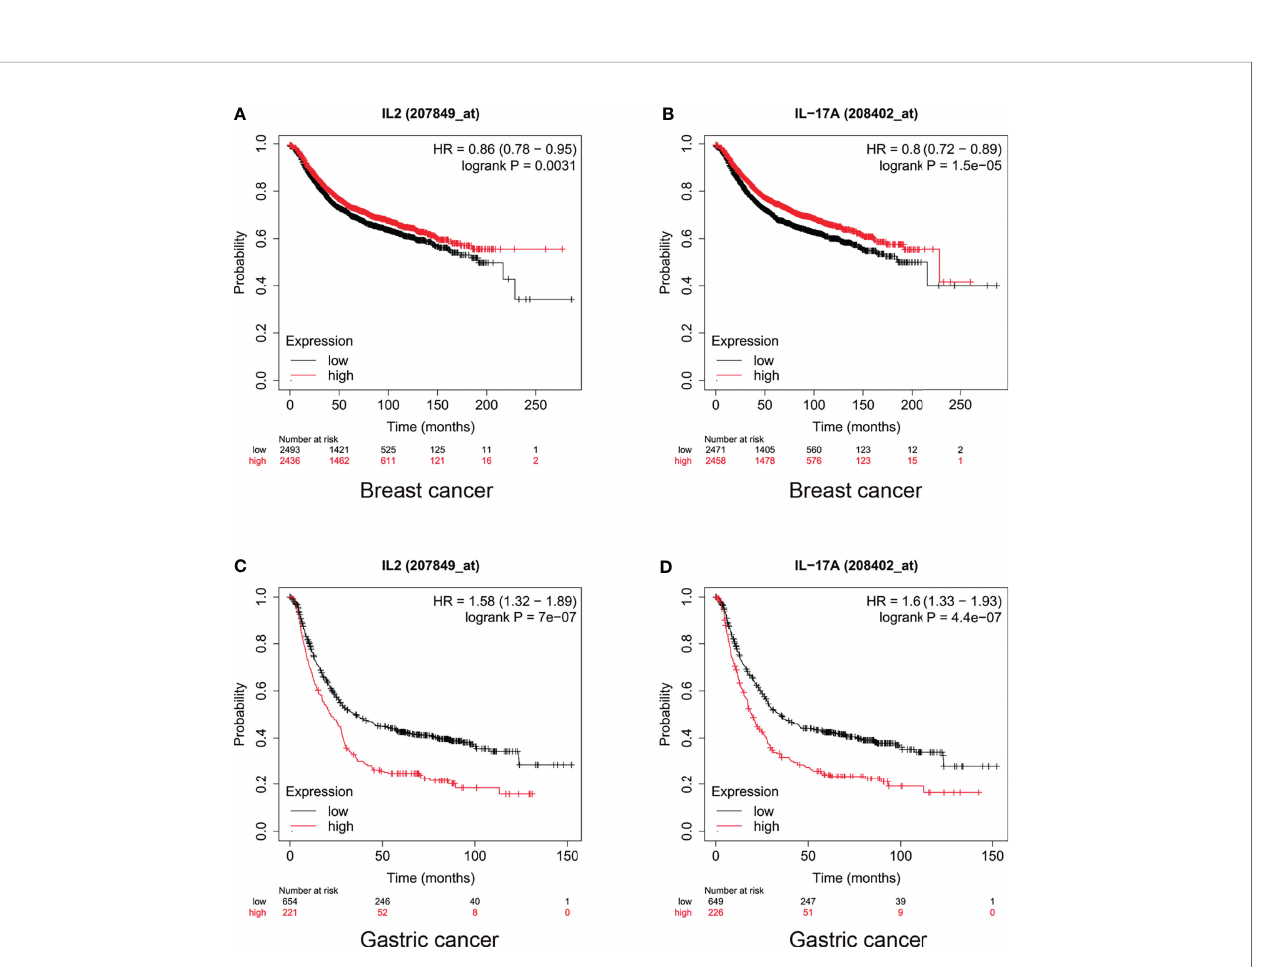
FIGURE 3 | Levels of interleukin (IL)-2 and IL-17 played different roles in breast and gastric cancer prognosis. High IL-17 and IL-2 expression indicated (A, B) promising prognosis in breast cancer and (C, D) poor prognosis in gastric